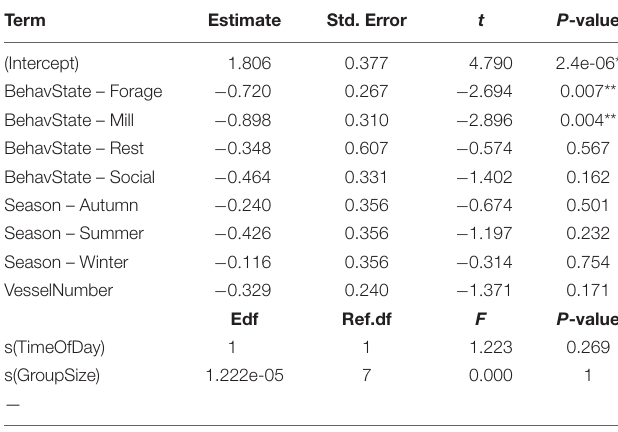
TABLE 7 | Summary of output for best fitting model for Indo-Pacific humpback dolphin linearity. Term